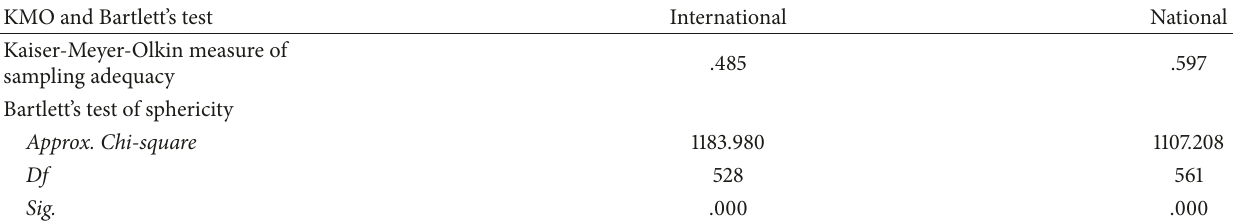
KMO and Bartlett’s